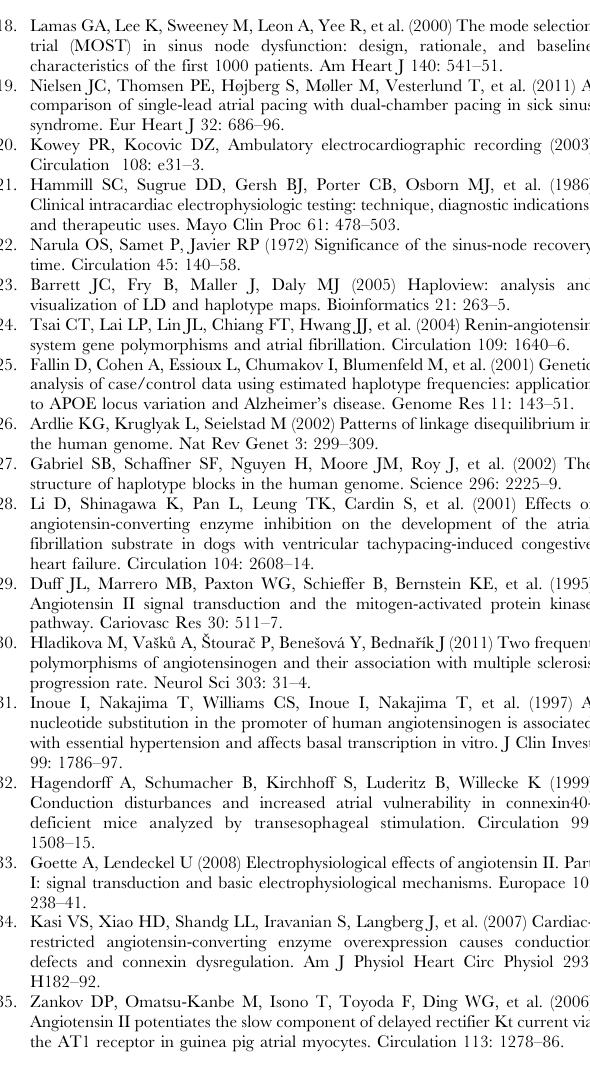
Figure S3 AGT G-217A genotyping by direct sequencing. The arrows indicate the polymorphic sites of GG, AA and AG genotypes. (TIF) Figure S4 Cx40 -44/ + 71 polymorphism genotyping by direct sequencing. The arrows indicate the polymorphic sites of the different genotypes.